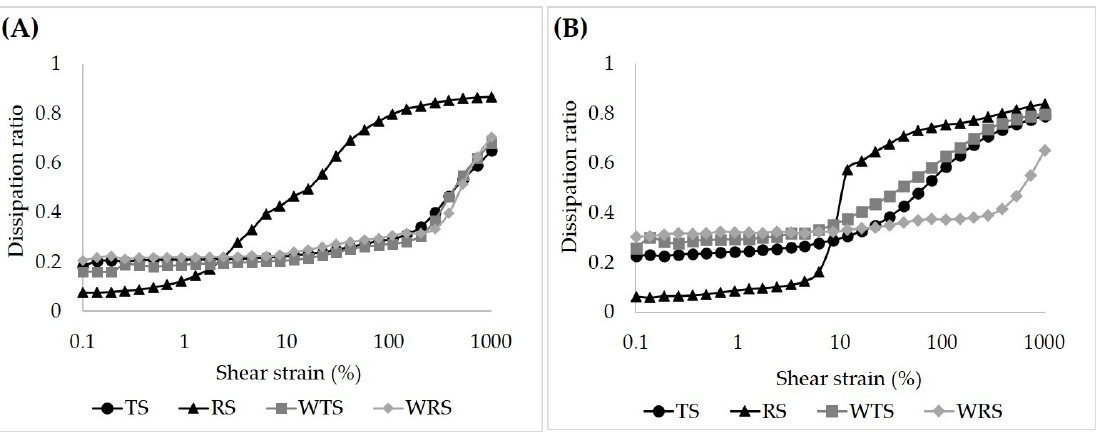
Figure 11. Dissipation ratio of native starch gels (6% w / v ): ( A ) neutral system and ( B ) sugar–acid system.